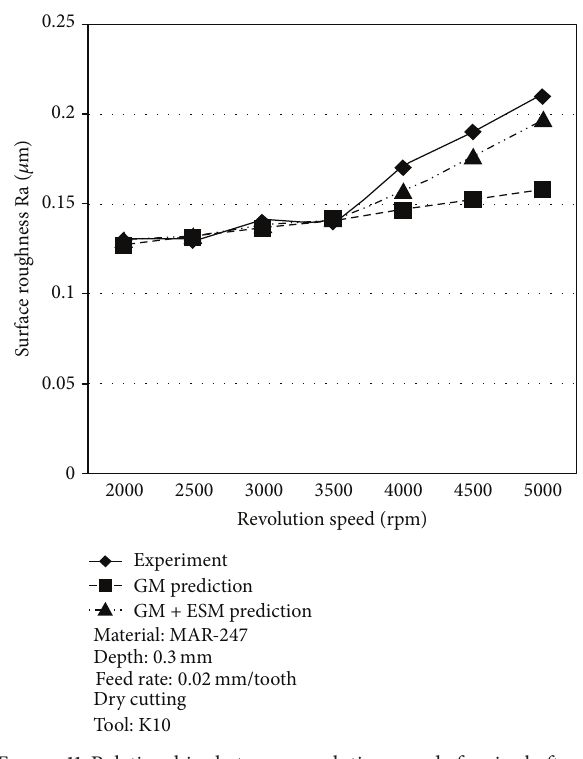
Figure 11: Relationships between revolution speed of main shaft and surface roughness.